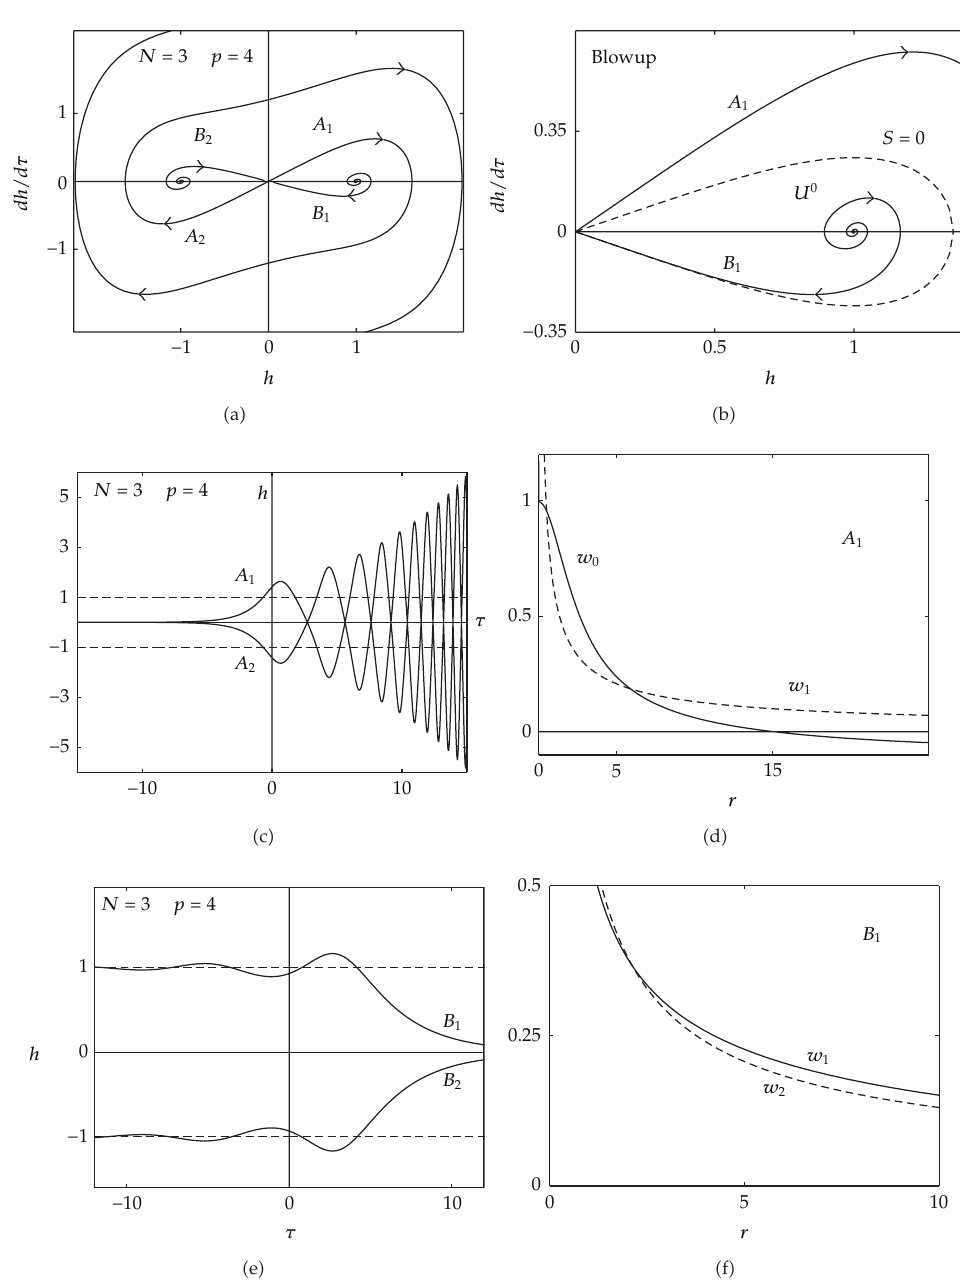
Figure 1: Subcritical example: N (cid:5) 3, p (cid:5) 4. (cid:6)(cid:6) a (cid:7) and (cid:6) b (cid:7)(cid:7) The unstable manifold (cid:6) A 1 and A 2 (cid:7) and stable manifold (cid:6) B 1 and B 2 (cid:7) lead from (cid:6) 0 , 0 (cid:7) into the (cid:6) h,h (cid:2) (cid:7) phase plane. (cid:6)(cid:6) c (cid:7) – (cid:6) f (cid:7)(cid:7) (cid:6) c (cid:7) and (cid:6) e (cid:7) show the h components of solutions on A generated by A 1 , w 2 (cid:6) r (cid:7) is the new positive singular solution generated by B 1 , and w 1 (cid:6) r (cid:7) (cid:5) (cid:6) 2 / 9 (cid:7) 1 / 3 r − 2 / 3